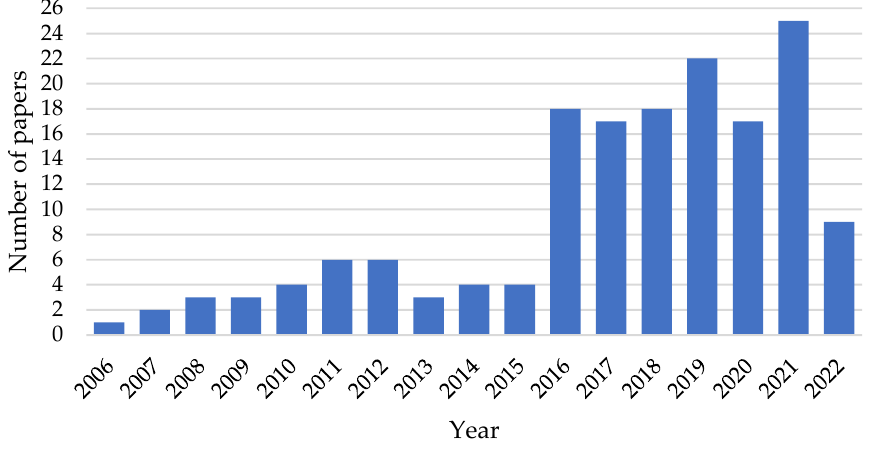
Figure 2. Number of papers per year.